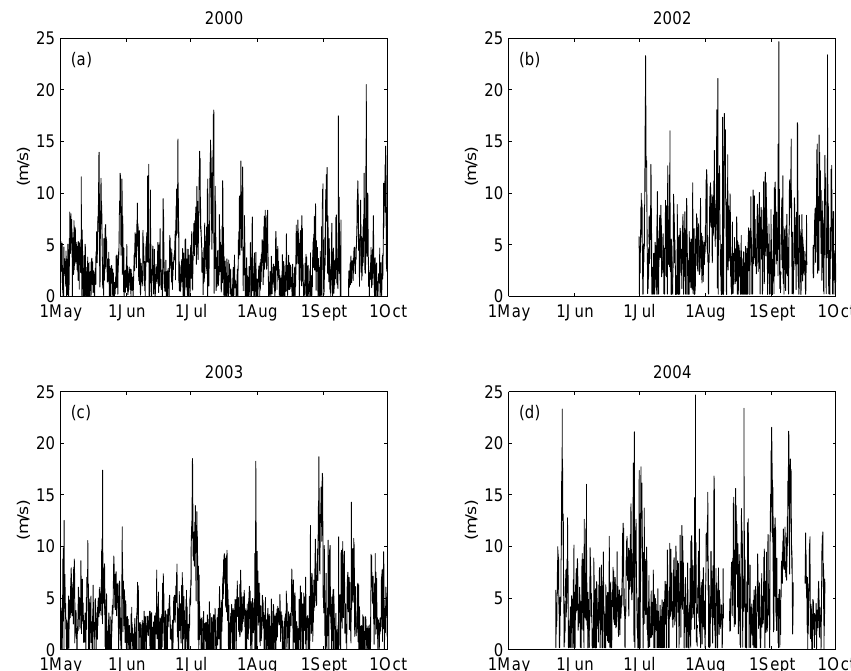
Fig. 6. Hourly wind speed (m s − 1 ) from May to September 2000 (a) , 2002 (b) , 2003 (c) , and 2004 (d)